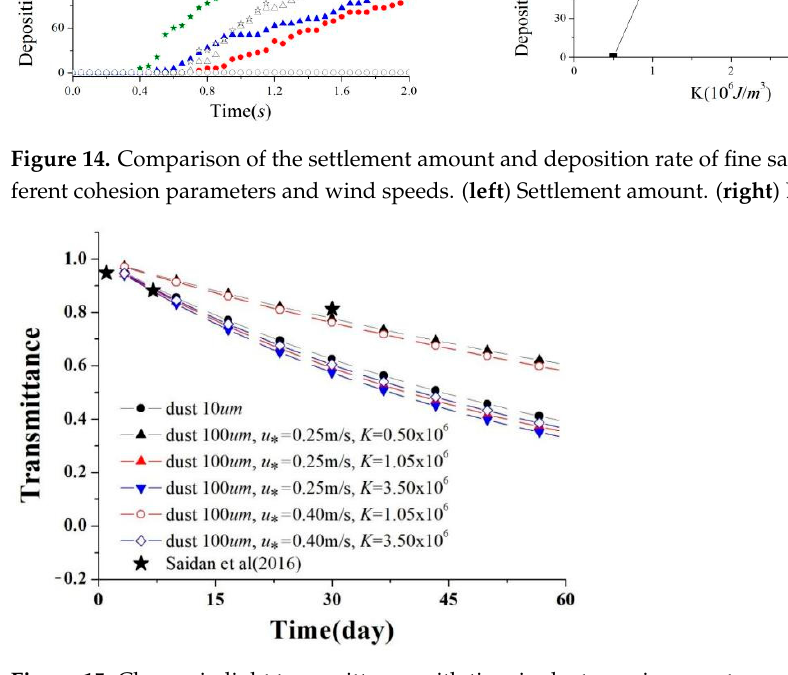
Figure 15. Change in light transmittance with time in dusty